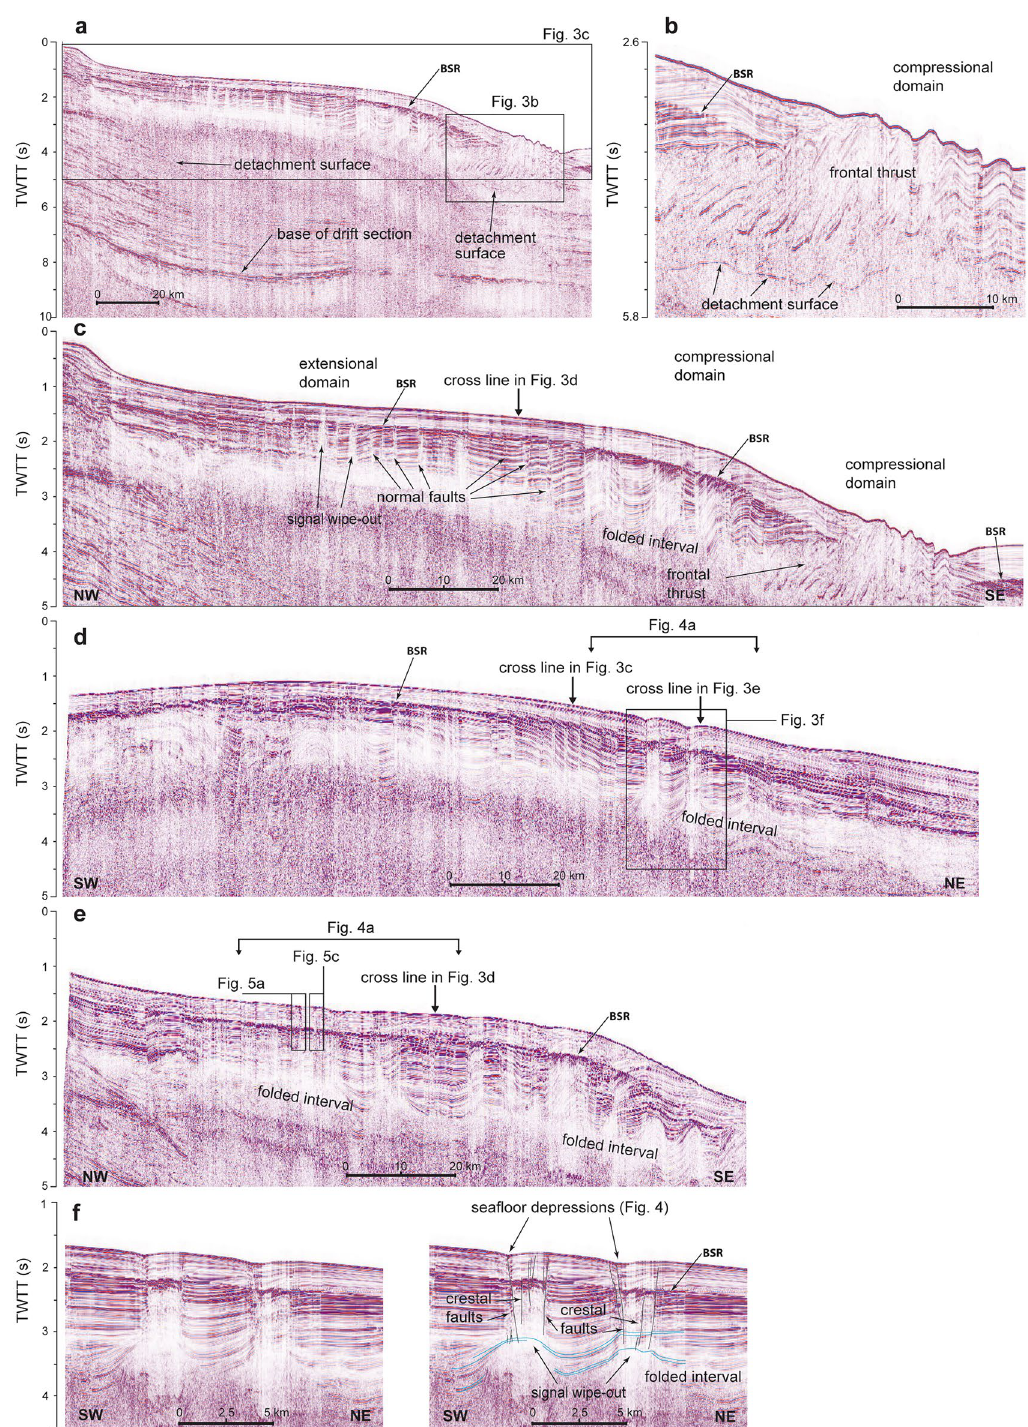
Figure 3. Seismic profiles illustrating tectonic and fluid migration structures within the Rio Grande Cone (see Fig. 1a for locations): ( a ) a deep profile imaging the main detachment surface of the Rio Grande Cone (RGC), the base of the drift section of the South Atlantic (Albian/Cenomanian 39 ) and the bottom simulating reflector (BSR). ( b ) Detail of ( a ) showing the frontal thrusts and the detachment surface. ( c ) Detail of ( a ) showing the BSR and the extensional (upslope) and the compressional (downslope) structural domains, and associated structures (normal faults and the thrusts is a fold-and-thrust belt, respectively). Some normal faults are associated with signal wipe-outs possibly related to the presence of free gas; most terminate at the BSR and do not reach the seafloor. The frontal thrusts in the deepest part of the compressional domain form elevations of up to 200 m in seafloor relief over the Oligocene–Miocene overpressured strata. ( d ) Section showing structures rooted at the Miocene folded interval and reaching the seafloor (details in Fig. 2f). ( e ) Section showing another example of structures rooted at the folded Miocene interval and reaching the seafloor (details in Fig. 4a,c). ( f ) Detail of ( d ) showing uninterpreted section (left) and crestal faults (black lines, right) rooted on the anticlines in folded interval (right); note a seafloor depression associated with the crestal faults and the signal wipe-out zone connecting the buried anticlines to the seafloor. Light-blue lines are drawn to facilitate the correlation of seismic reflections in folded strata. See Fig. 1 for location of